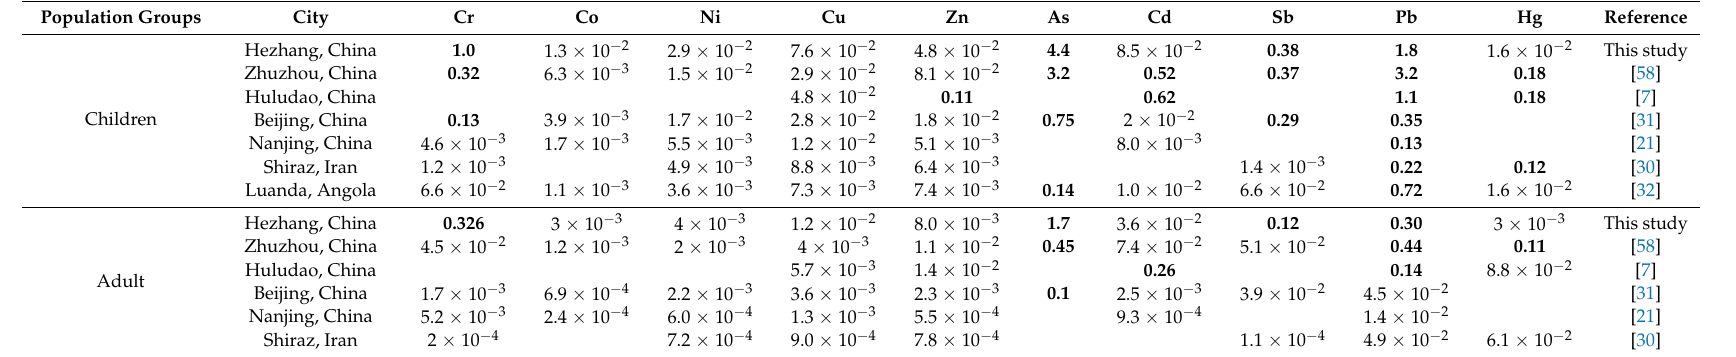
Table 9. Comparisons of HIs for trace metal(loid)s in street dust of different